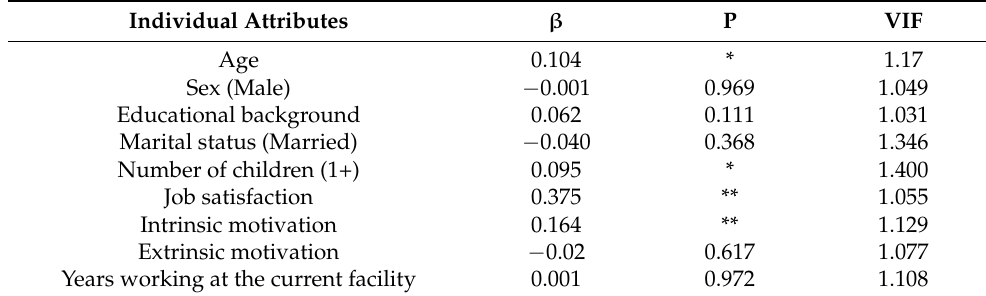
Table 5. Impact of work motivation on work